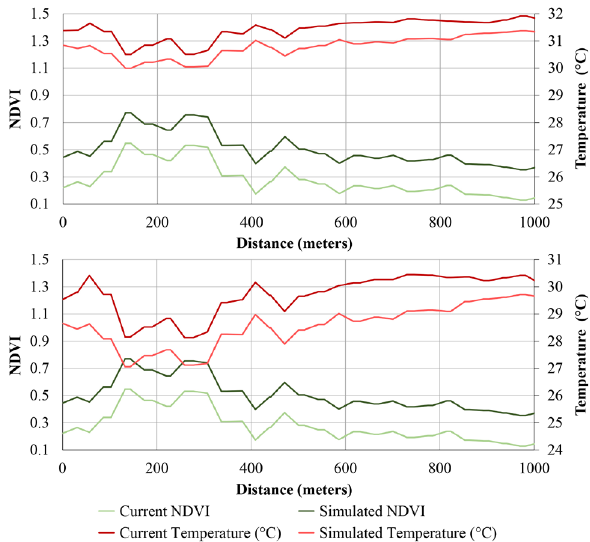
Figure 6. Current and simulated NDVI and near-surface air temperature along segment EF for daytime (top) and night-time (bottom)